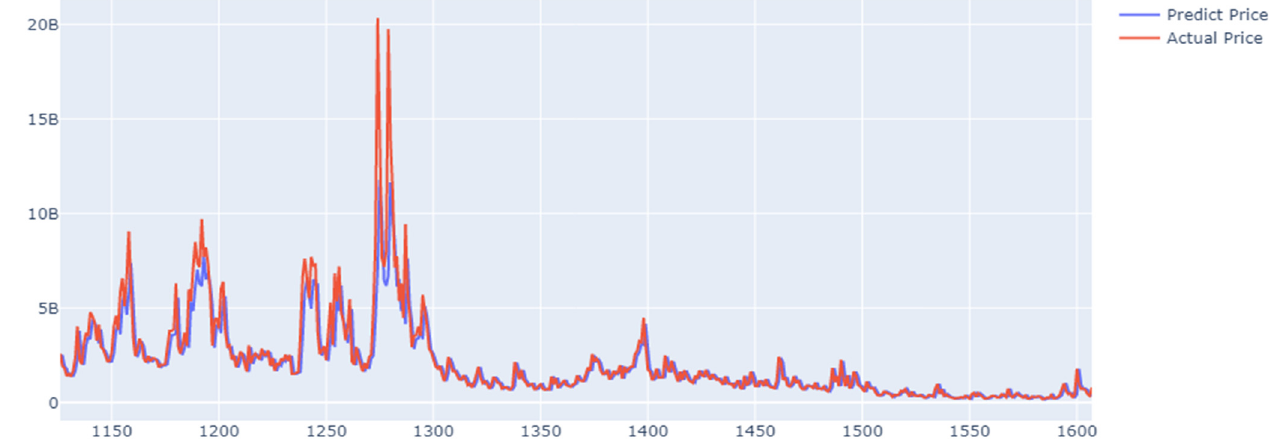
Figure 11. Time series plot of the LSTM model in predicting the prices of the EOS cryptocurrency.